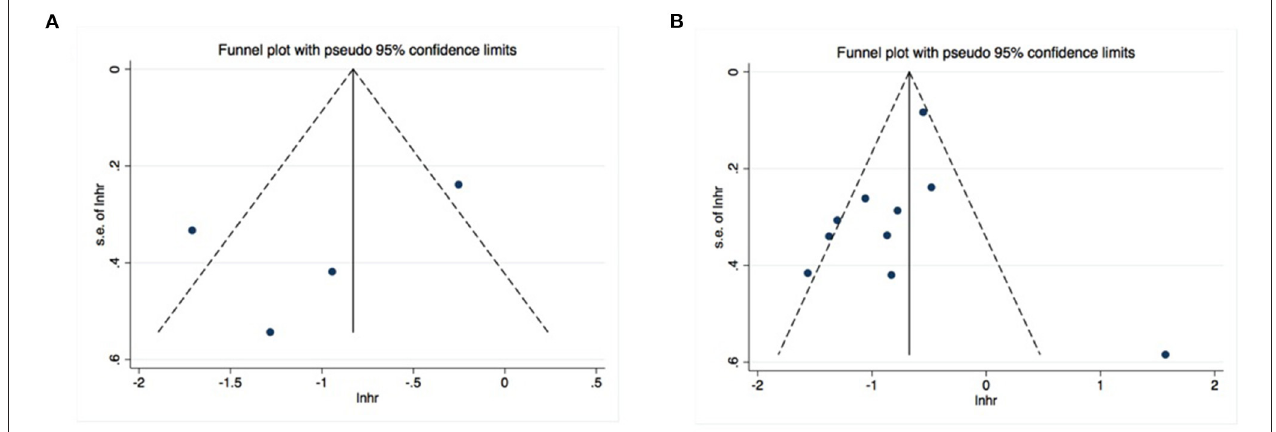
FIGURE 5 | No significant publication bias existed in the pooled analysis about disease-free survival (A) or overall survival (B)